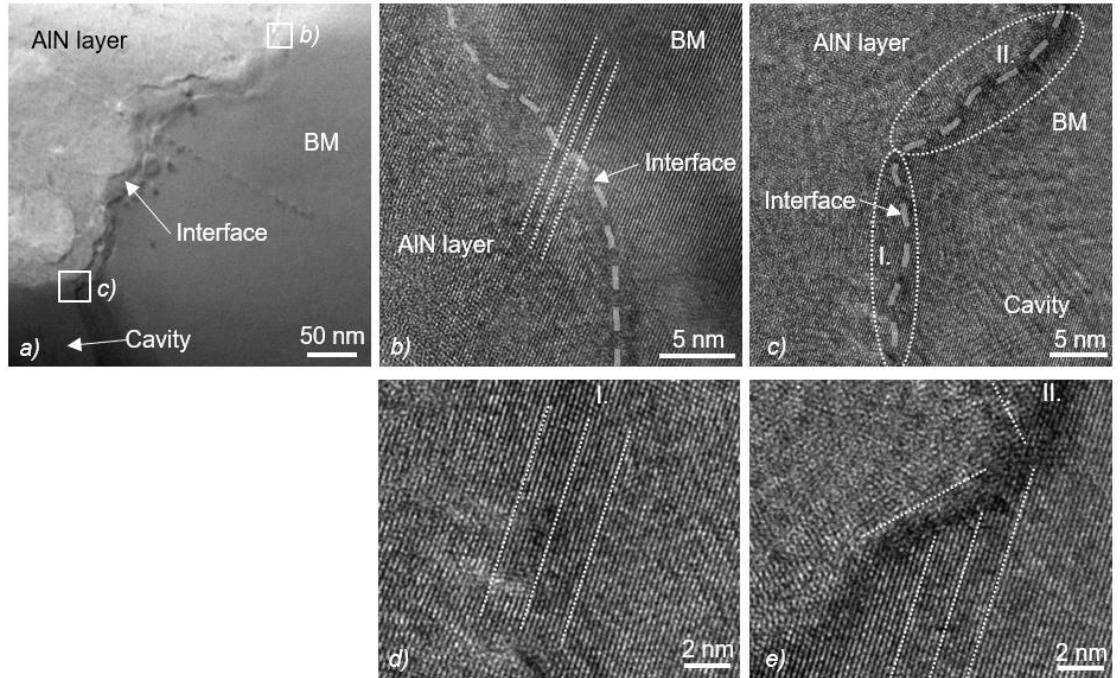
Figure 6. HRTEM images focussed on the interface (dotted line) between the AlN layer and the Al base material: ( a ) overview, ( b ) without, and ( c ) with diffusion-induced cavity after nitriding; higher resolution images of interfacial areas I., II.: ( d ) area I. with coherent bonding, and ( e ) area II. with incoherent bonding (dotted lines: exemplary lattice planes).